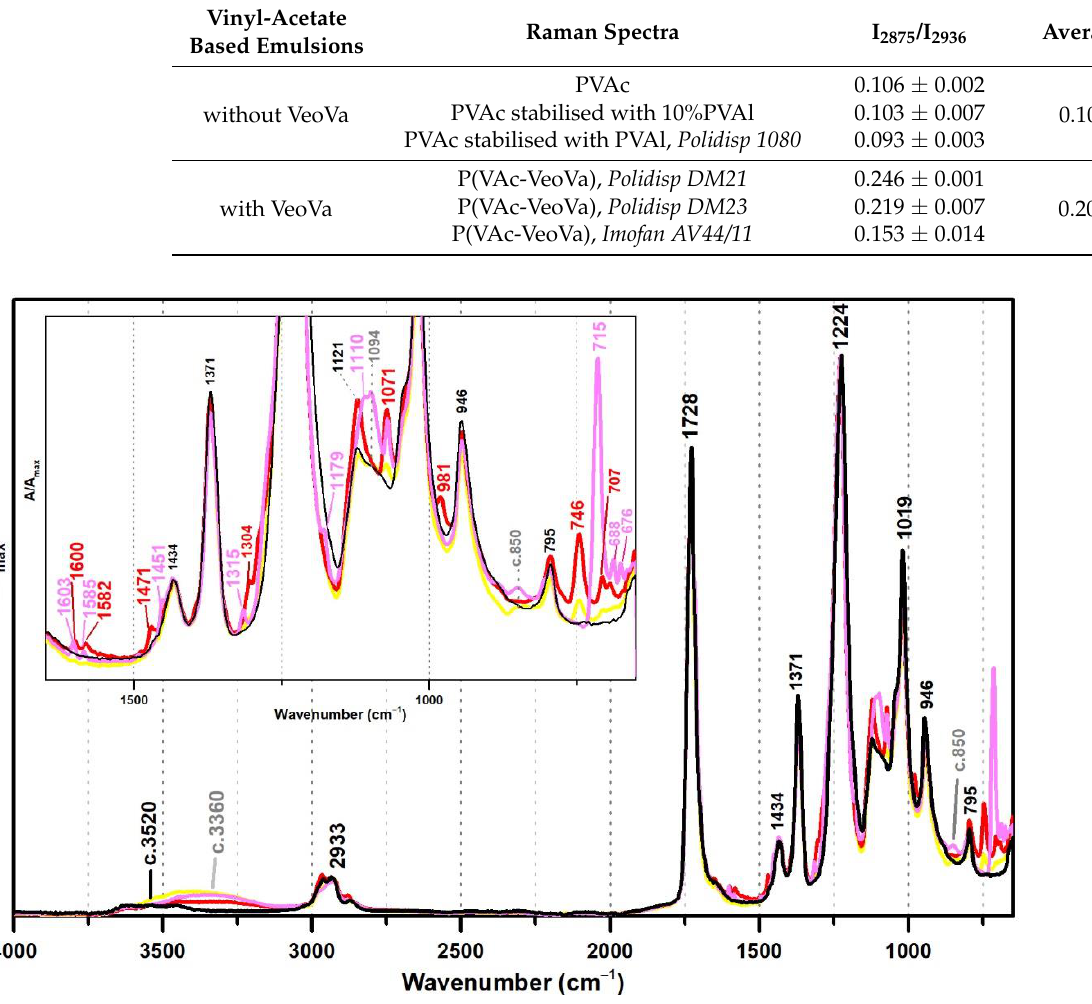
Figure 5. Infrared spectra in ATR of the pure PVAc emulsion (black), Bizonte (pink), Vulcano V7 (red) and Imofan AV44/11 (yellow). Inset: detail between 1650 and 650 cm −1 . According to the authors of [5], Bizonte is composed of PVAc plasticised with DPGDB and DEGDB, Vulcano V7 is composed of PVAc plasticised with DiBP, and Imofan AV44/11 is composed of P(VAc-VeoVa) plasticised with DiBP.